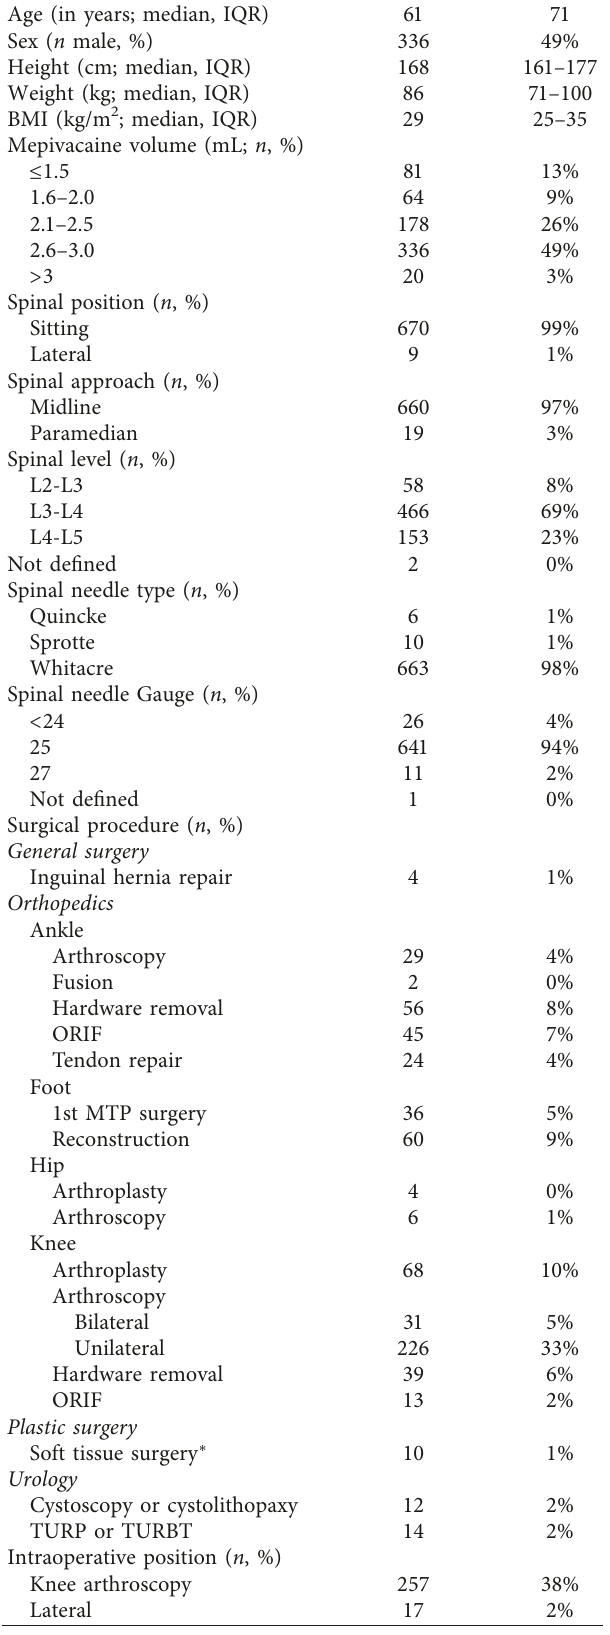
Table 1: Cohort characteristics ( n � 679 mepivacaine spinal